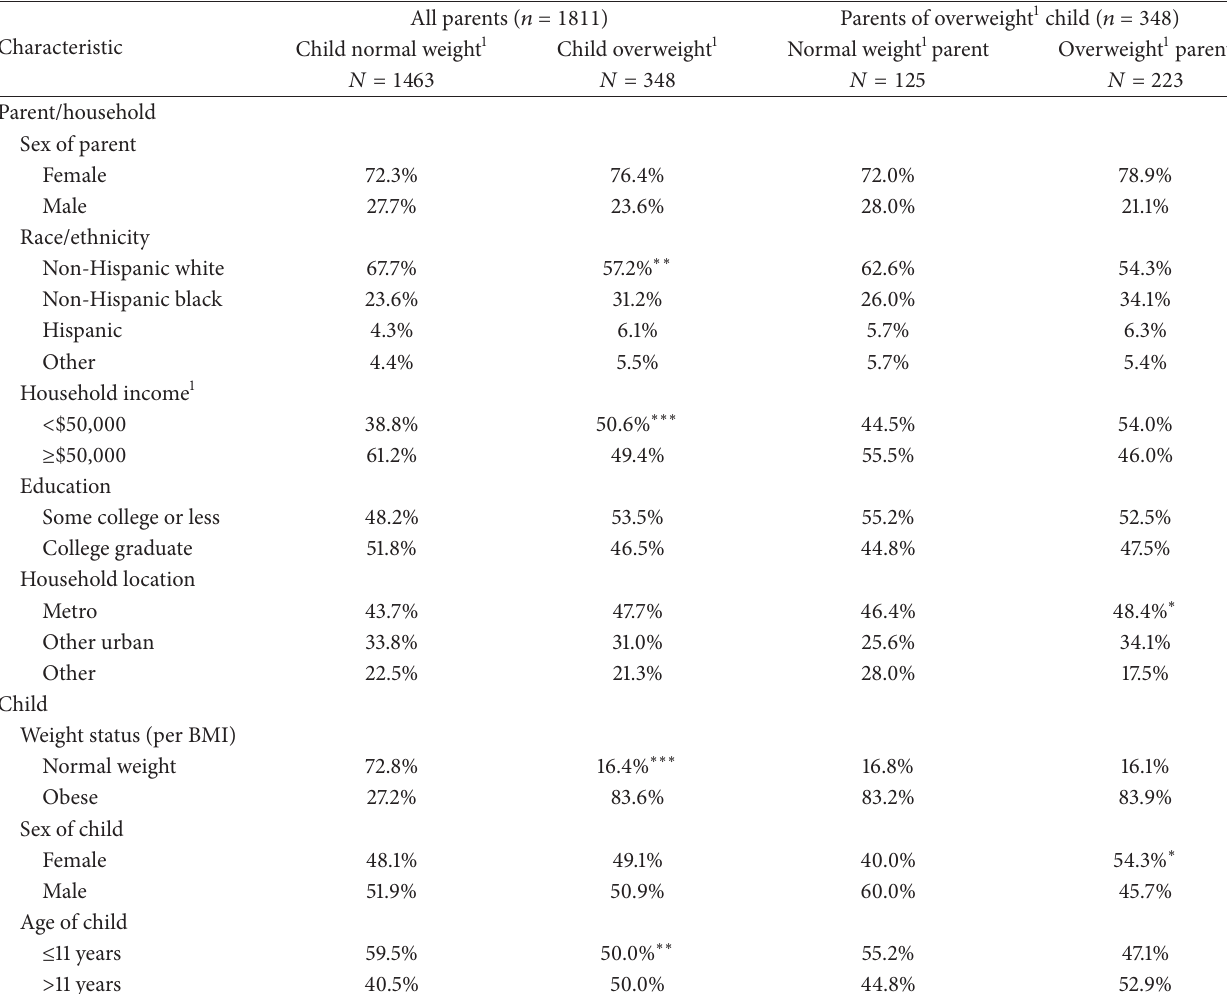
Table 1: Characteristics of parents stratified by perceived child’s weight status ( 𝑛 = 1811 ) and by parents’ self-reported weight status only among parents who perceived their child as